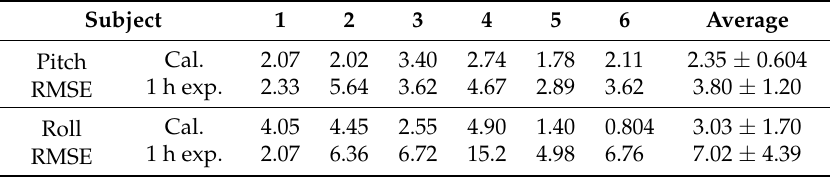
Table 6. RMS error in the calibration and one-hour